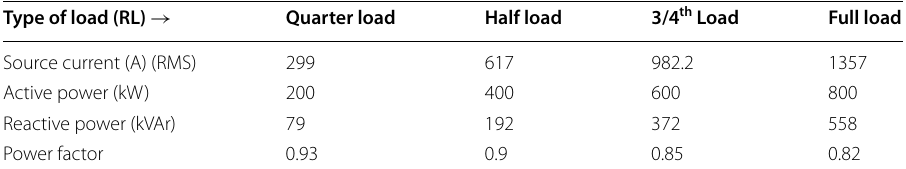
Table 2 Load details without controller